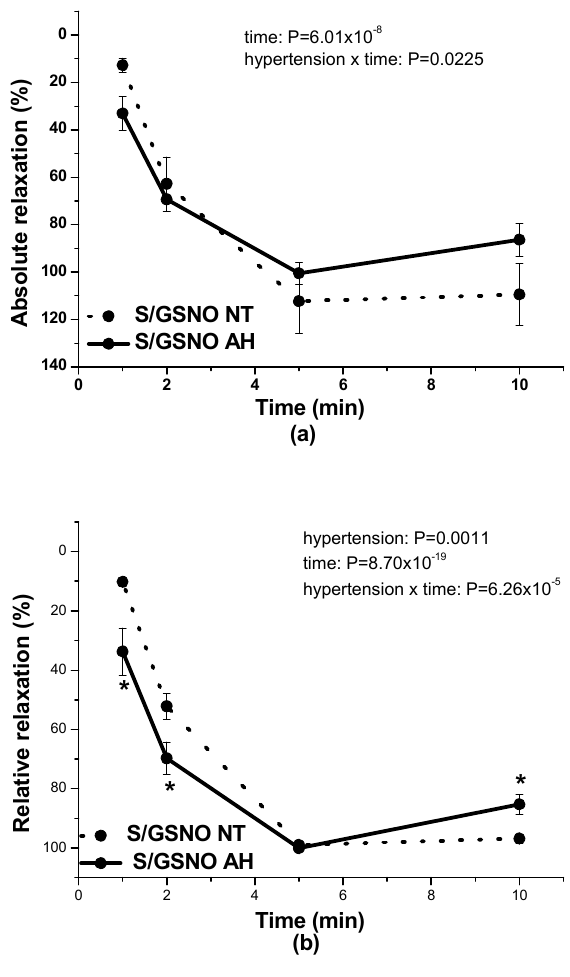
Figure 6 . The comparison of vasorelaxations of human lobar arteries induced by S/GSNO (0.5 µmol/L) products between normotensive patients (NT) and patients with arterial hypertension (AH). The absolute vasorelaxant responses are expressed as a percentage of the serotonin (1 µmol/L)-induced contraction ( a ) The relative vasorelaxant responses (revealing the speed of the vasorelaxation) are expressed as a percentage of the maximal relaxation ( b ). Results are expressed as the mean ± S.E.M. Significant differences were evaluated by two-way ANOVA for main factors: hypertension and time. Bonferroni post hoc test was used to describe the differences in mean values of the experimental groups. * p < 0.05 with respect to the value of the S/GSNO NT response.